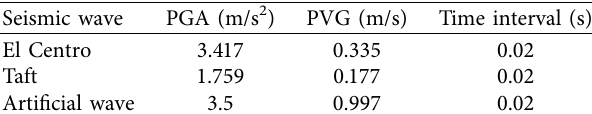
Table 3: Characteristics of earthquake